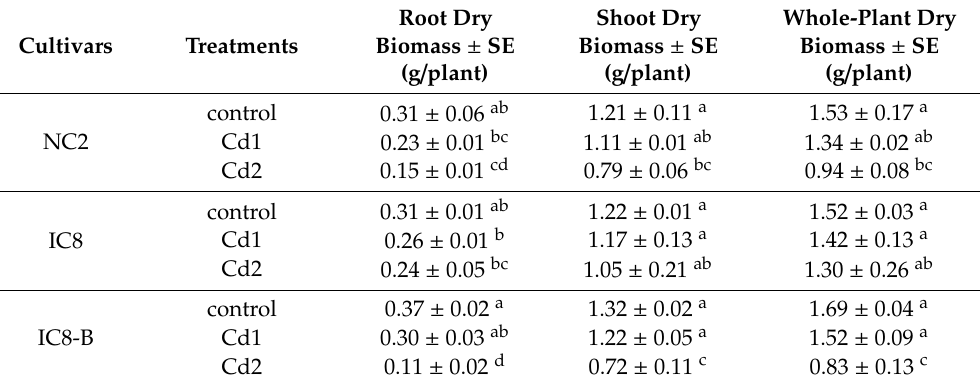
Table 3. Dry biomasses of the root, shoot and total plant of chickpea seedlings grown in a nutrient medium under Cd stress at the rate of 0 µ M (control), 25 µ M (Cd1) and 50 µ M (Cd2) with mean values ± SE, ( n = 3).